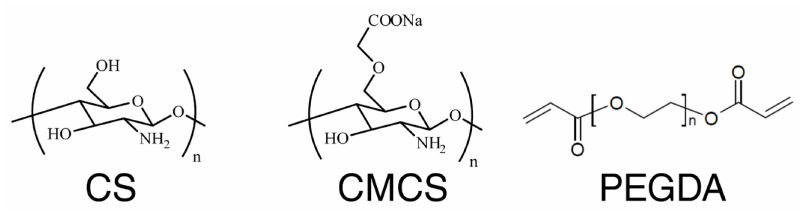
Figure 1. Structure of chitosan (CS), carboxymethyl chitosan (CMCS), and poly(ethylene glycol) diacrylate